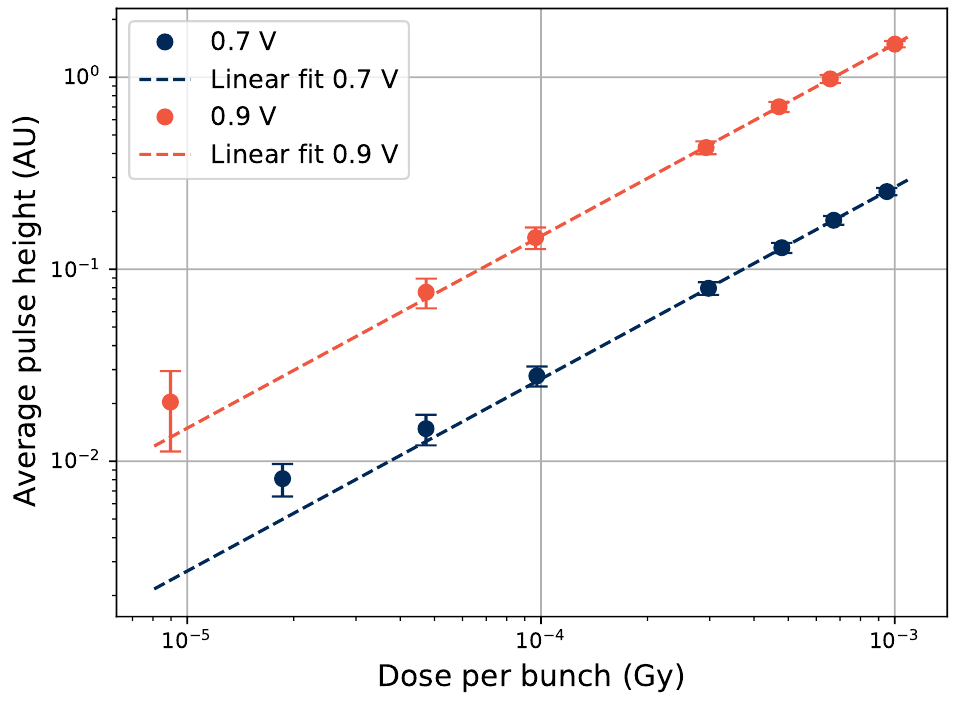
Figure 8. Pulse height as a function of electron bunch size in the Gd-doped sample at varying PMT gain